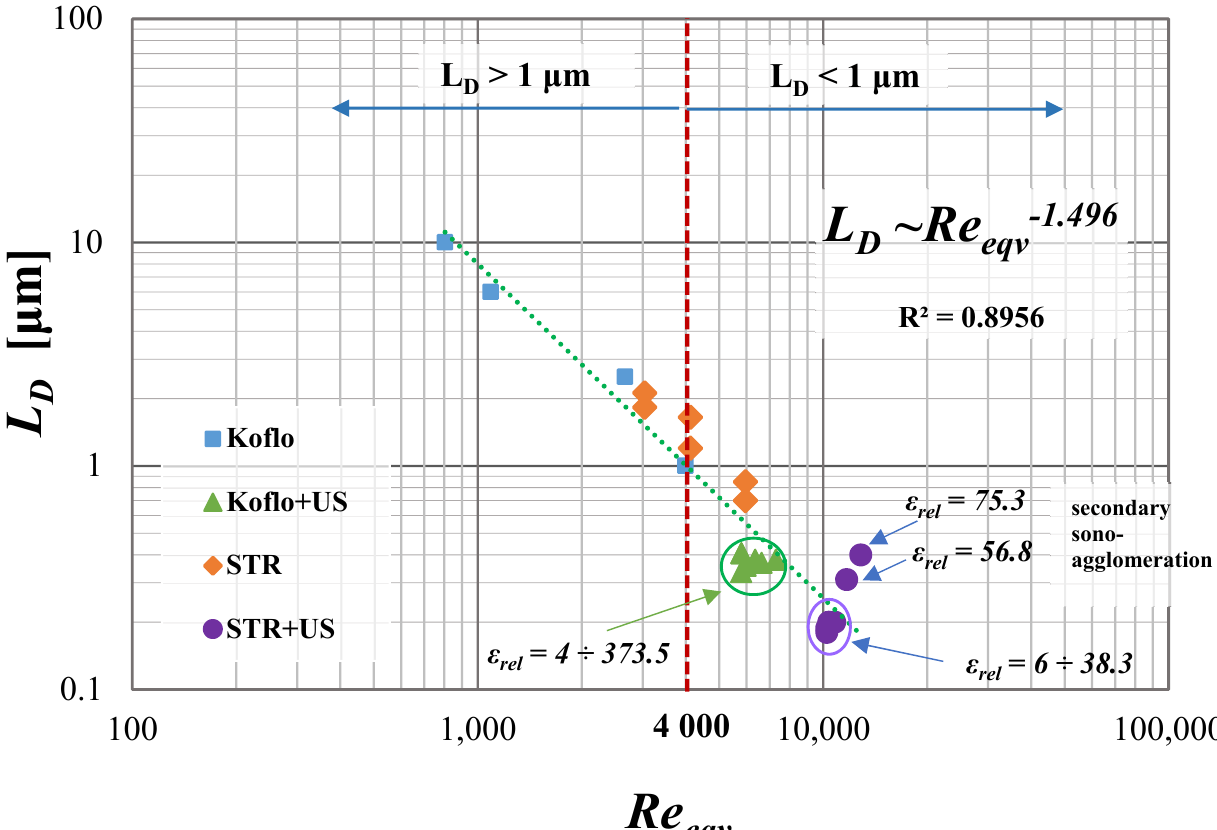
Figure 10. The dominant particle size L D as the function of equivalent Reynolds number Re eqv for all of the tested reaction systems.